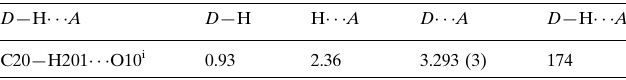
Hydrogen-bond geometry (A˚ , (cid:4) ). D —H (cid:1)(cid:1)(cid:1)